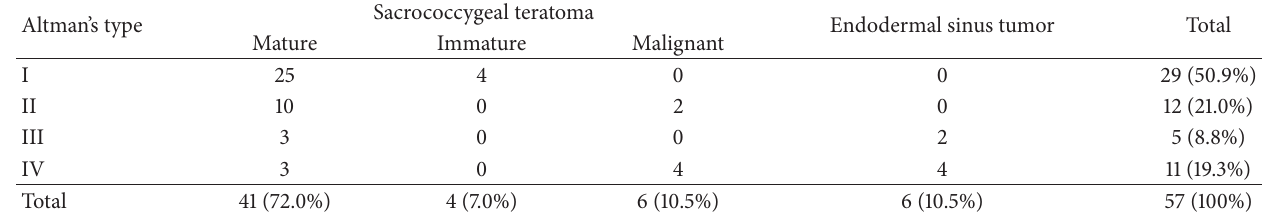
Table 2: Anatomical types of sacrococcygeal germ cell tumors and risk of malignancy.